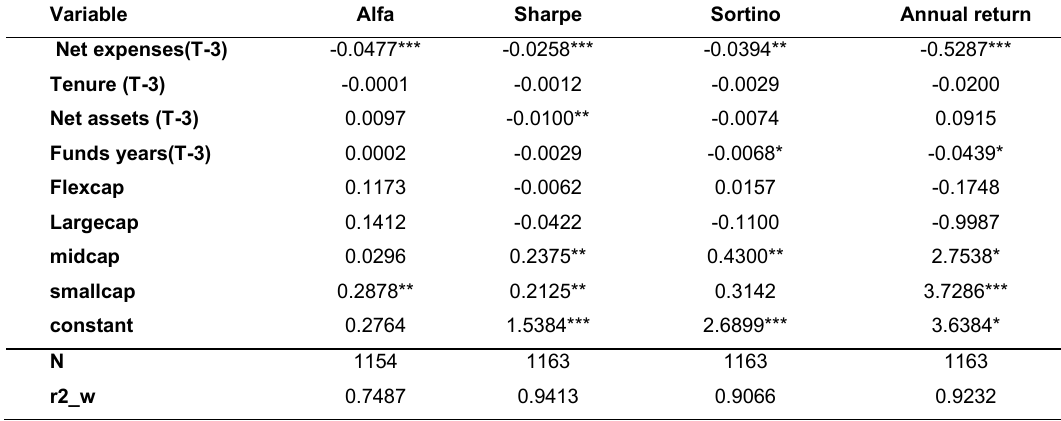
Table 3 . Regression of panel data, of the expense ratio (T-3) of funds with respect to their performance, with random effects.